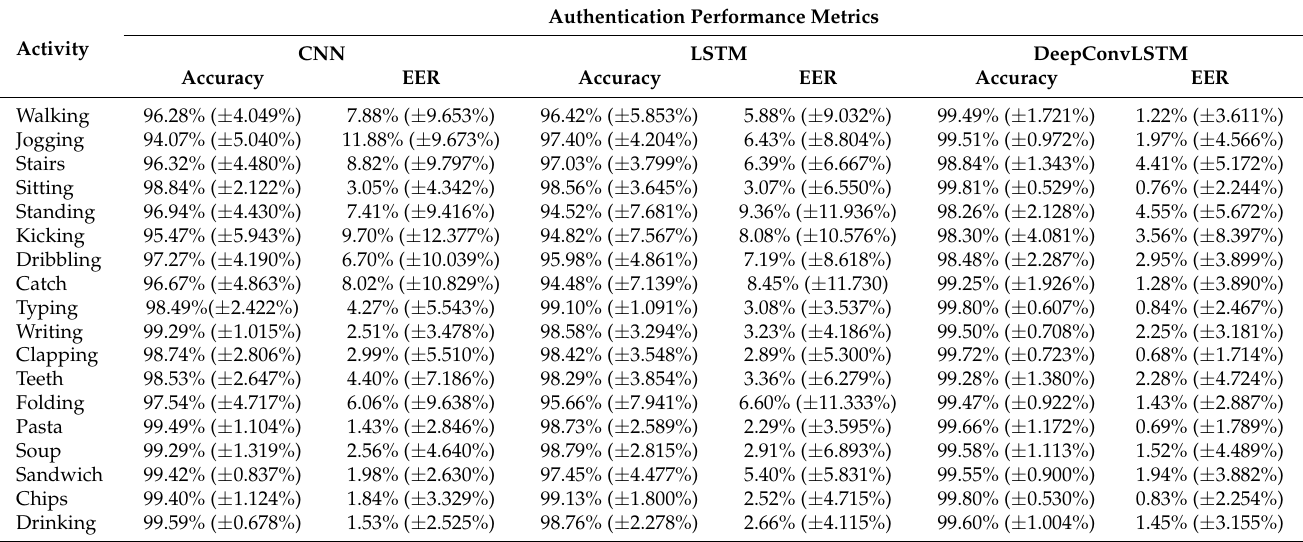
Table 9. Average metrics on classifier evaluation of deep learning models using WISDM-HARB dataset.